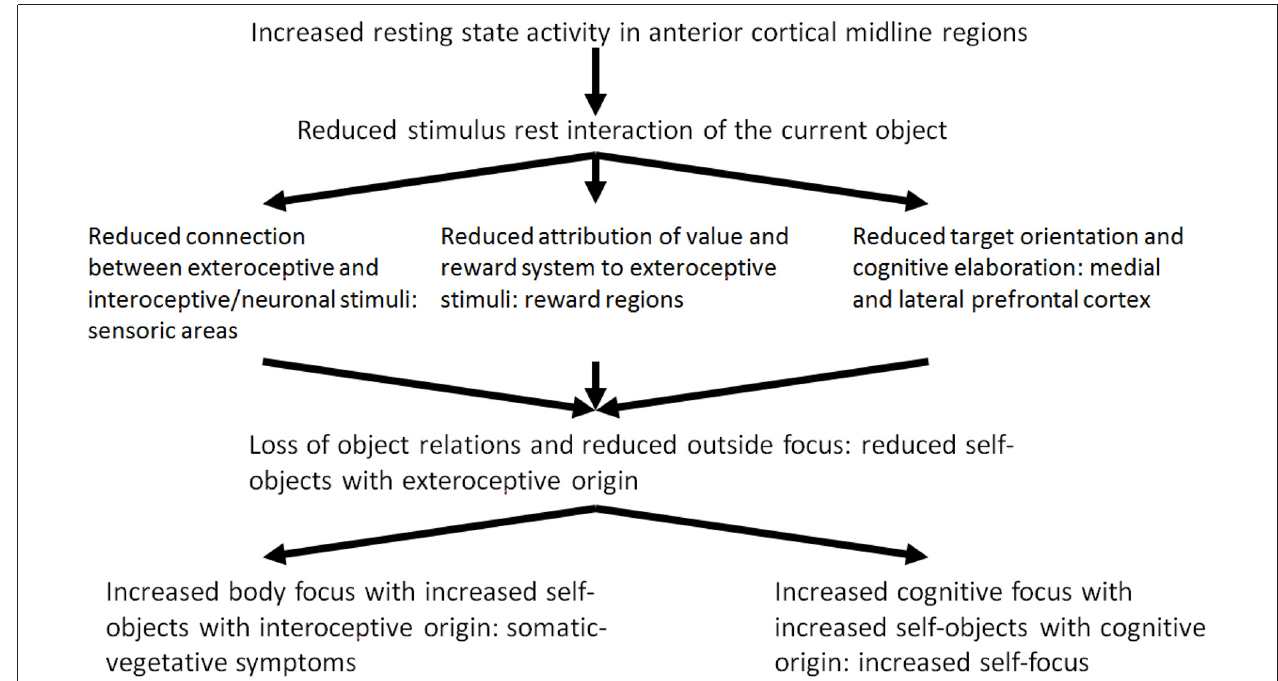
FIGURE 2 | Reduced stimulus-rest-interaction, reduced outside focus and increased